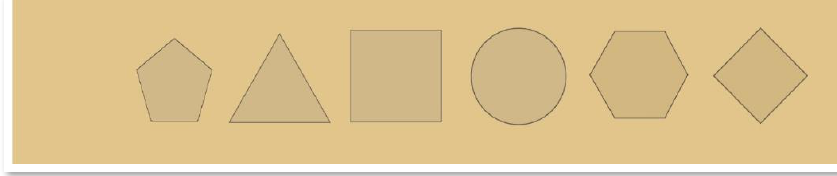
Figure 10. Multiple shape wooden board.